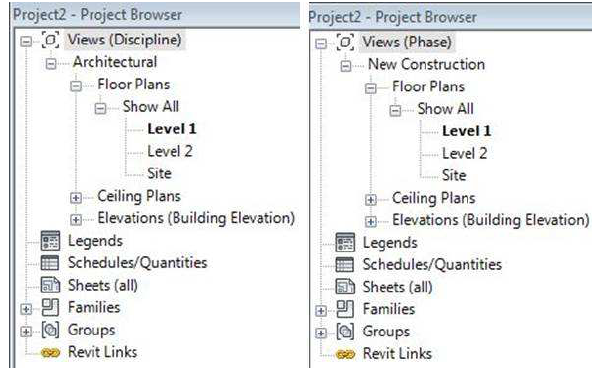
Figure 7. Browser organization of the 3D